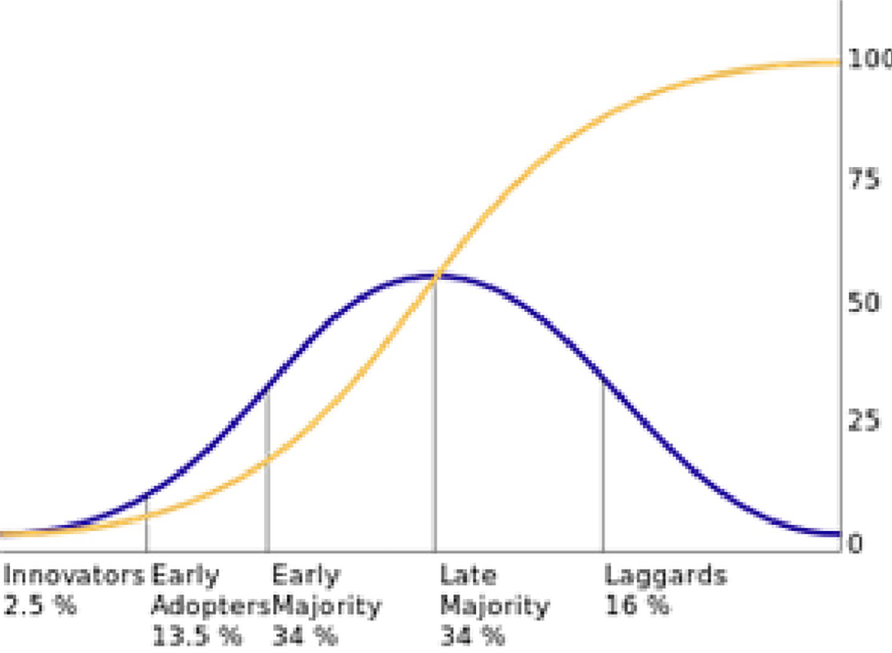
Fig 1. Adoption/Infection stages based on relative time and growth. (Robertsonm 1967, p. 16, Rogers 2003, p. 280).